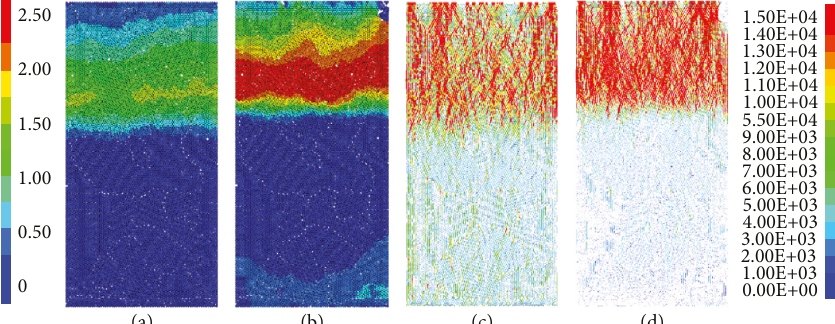
Figure 15: Instantaneous velocity and stress distribution: (a) instantaneous velocity of particles with 50% amplitude, (b) instantaneous velocity of particles with 100% amplitude, (c) stress distribution with 50% amplitude, (d) stress distribution with 100%